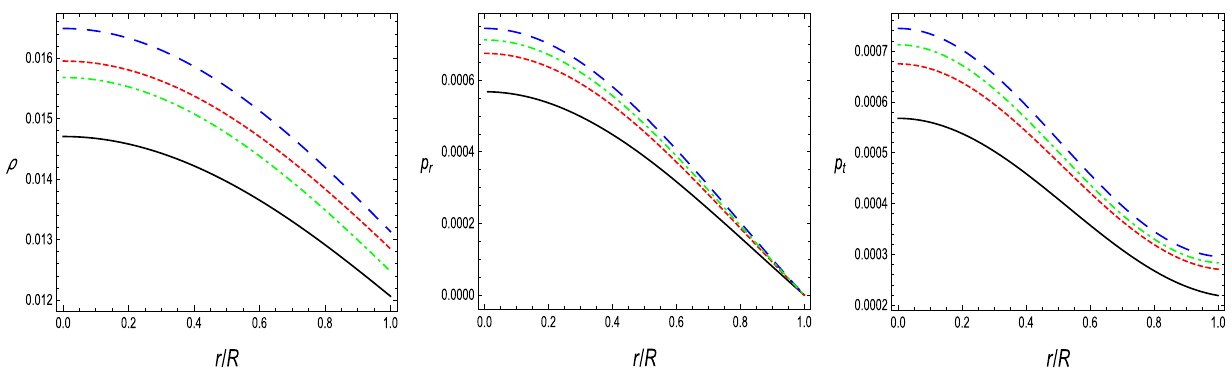
4 . 1 × 10 − 5 ,δ = 0 . 00154136 ,γ = − 13 . 7591, (iii) SAX J1808.4-3658 (blue curves) for α = − 2 . 3 , C = 0 . 5 ,η = 13 ,β = − 0 . 177 , k = 6 . 1 × 10 − 5 ,δ = 0 . 0015934 ,γ = 2 . 78488, (iv) SMC X-1 (green curves) for α = − 2 . 3 , C = 0 . 5 , η = 14 ,β = − 0 . 177 , k = 0 ,δ = 0 . 00151507 ,γ = 1 . 06768